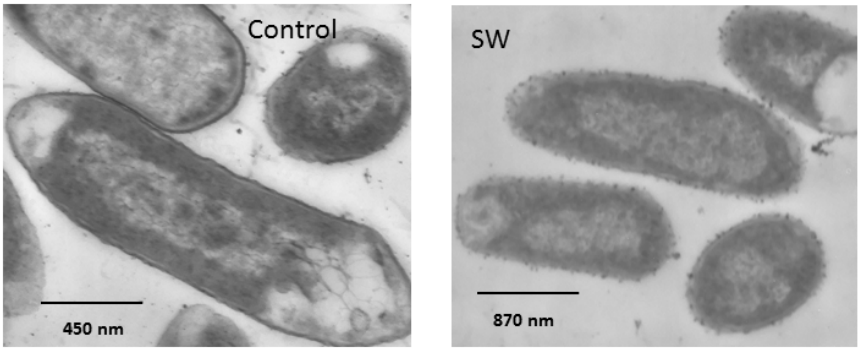
Figure 5. Effect of tannins isolated from purple prairie clover ( PPC; Dalea purpurea Vent.), sainfoin (SF; Onobrychis viciifolia ) and brown seaweed (SW; Ascophyllum nodosum ) on cell membrane of Escherichia coli (strain ATCC 25922). E. coli was aerobically cultured in M9 media containing no tannins (Control) or containing 50 µg of condensed tannins isolated from PPC or SF or 25 µg/mL phlorotannins from SW for 12